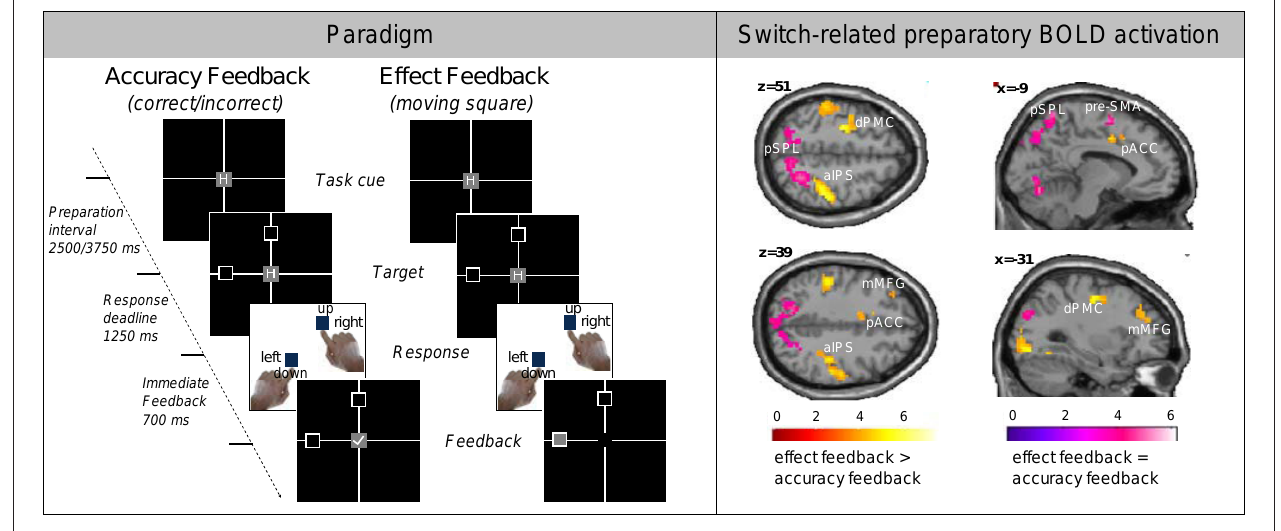
preparatory BOLD activations were identified, associated either with “ intentional preparatory control ” processes (stronger switch-related activation in the effect-feedback condition than in the accuracy feedback condition) colored in red/yellow or with “ attentional preparatory control ” processes (similar switch-related activation for both feedback types) colored in